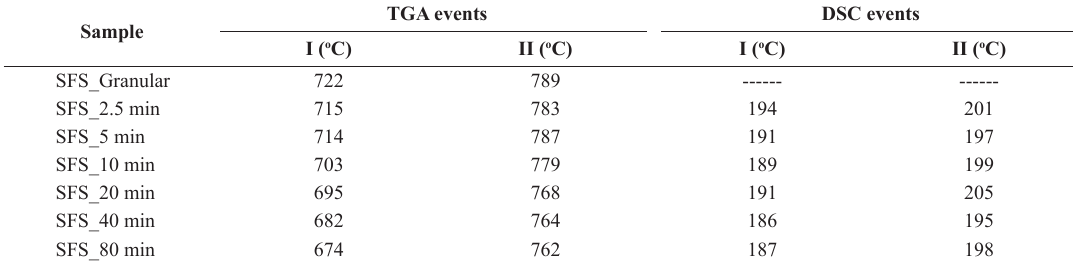
Table 3. Summary of TGA and DSC data of SSP fertilizer samples. Sample